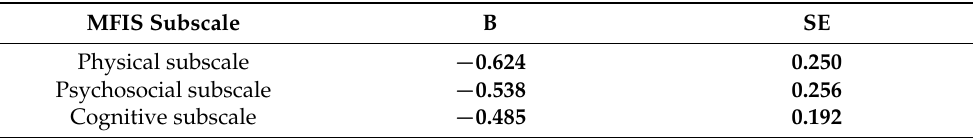
Table 3. Indirect effects by fatigue subscales, derived from three separate path analyses of the predictors depression and fatigue, on health-related quality of life (EQ-VAS) in persons with MS ( n = 206) 1 . MFIS Subscale B SE